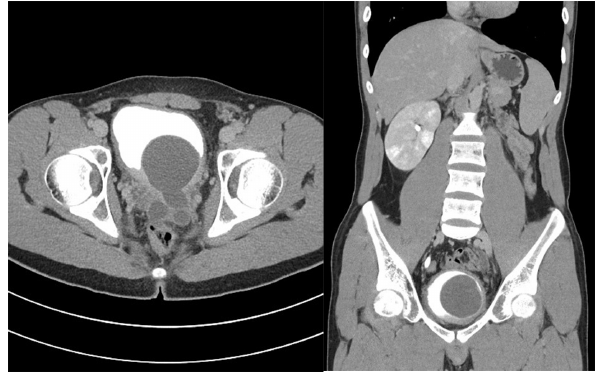
Fig. 2. Preoperative computed tomography showed a 5.7-cm left-sided ureterocele .